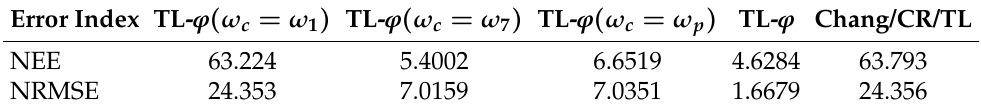
Table 9. Displacement errors for m 50 ( ˜ ω = 40 rad/s, %).